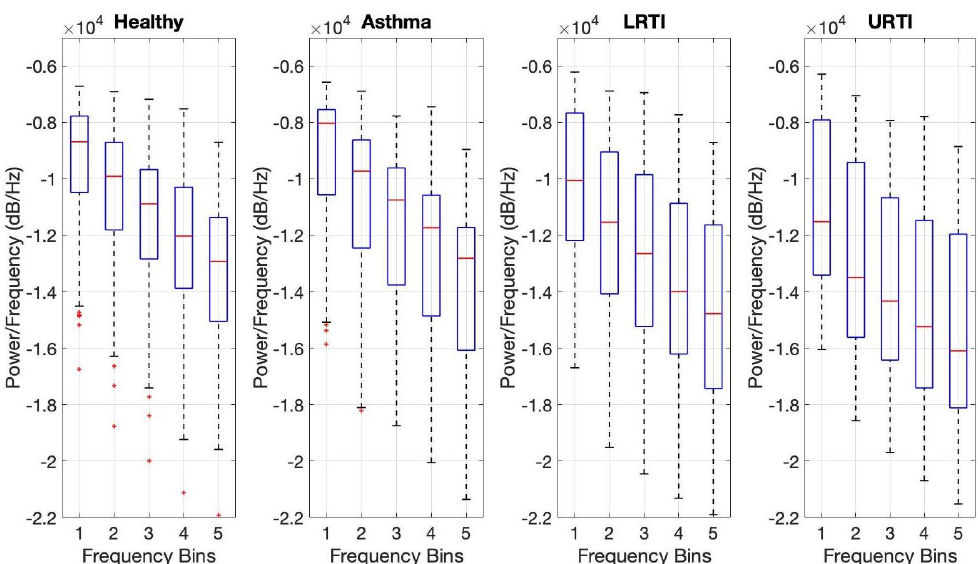
Figure 3. Boxplot showing the distribution of the power spectrum across various frequency bins: Bin 1—0 to 1.1 kHz, Bin 2—1.1 to 2.2 kHz, Bin 3—2.2 to 3.3 kHz, Bin 4—3.3 to 4.4 kHz, Bin 5—4.4